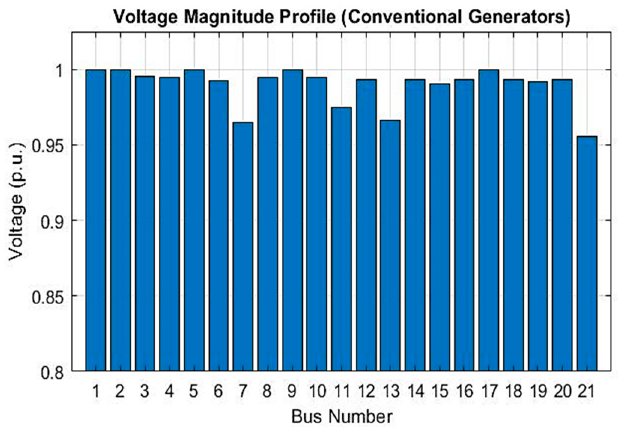
Figure 2. One-line diagram of the IEEE 21-bus microgrid system with synchronous generators implemented in PSAT software.